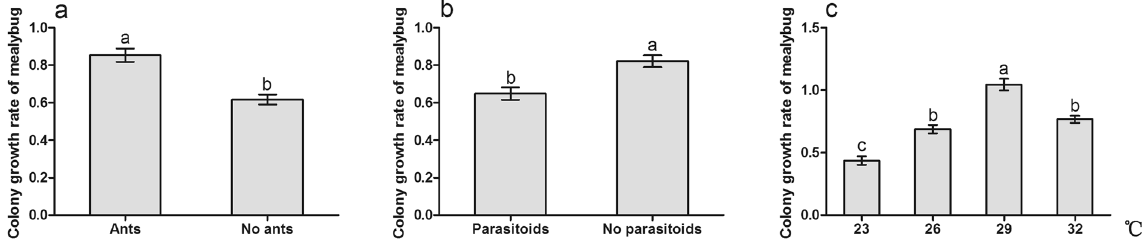
Figure 1. Effect of ant tending, the presence of parasitoids, temperature warming on mealybug colony growth. ( a ) Ant tending; ( b ) Parasitoid; ( c ) Temperature. Results are expressed as the means ± SE. Bars sharing the same letters indicate no significant differences between the treatments ( P > 0.05).